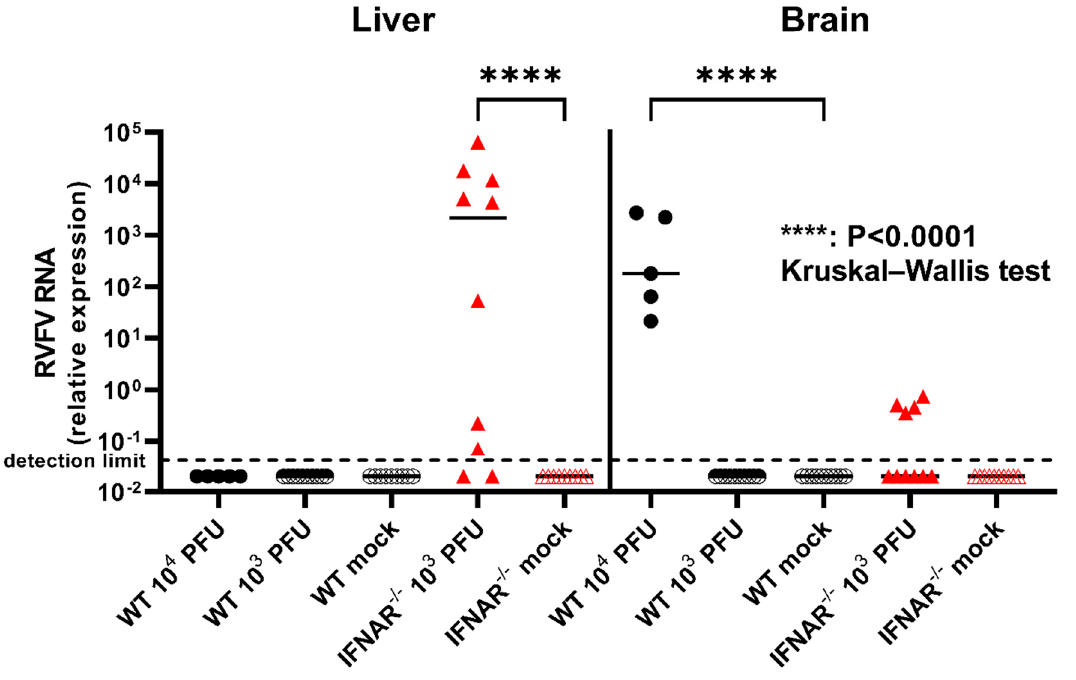
Figure 6. Reverse transcription-quantitative polymerase chain reaction (RT-qPCR) of liver and brain of wild type (WT) and type I interferon receptor knockout (IFNAR − / − ) mice. In all five WT mice infected with 10 4 plaque-forming units (PFU) Rift Valley fever virus (RVFV) viral RNA was detected in the brain at 7–21 days post infection (dpi), whereas viral RNA was present in the liver of eight out of ten IFNAR − / − mice infected with 10 3 PFU RVFV (2–21 dpi). Note low amount of viral RNA in the brain of four IFNAR − / − mice with fatal disease (2–5 dpi). Relative expression of RVFV RNA was calculated by synchronal detection of β -actin as housekeeping gene. Shown are all data points with median values (lines). Kruskal–Wallis test with Dunn’s correction: **** p < 0.0001.